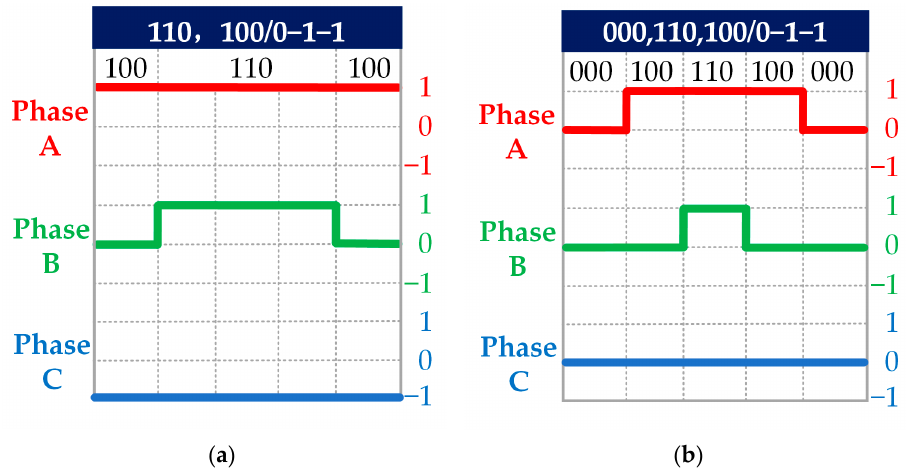
Figure 8. Double-vector and three-vector sorting methods. ( a ) Double-vector sorting method; ( b ) Three-vector sorting